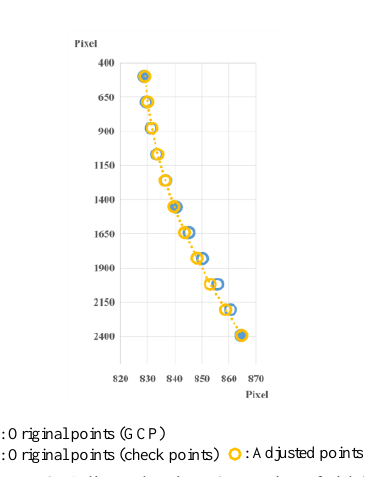
Figure 8. Adjusted